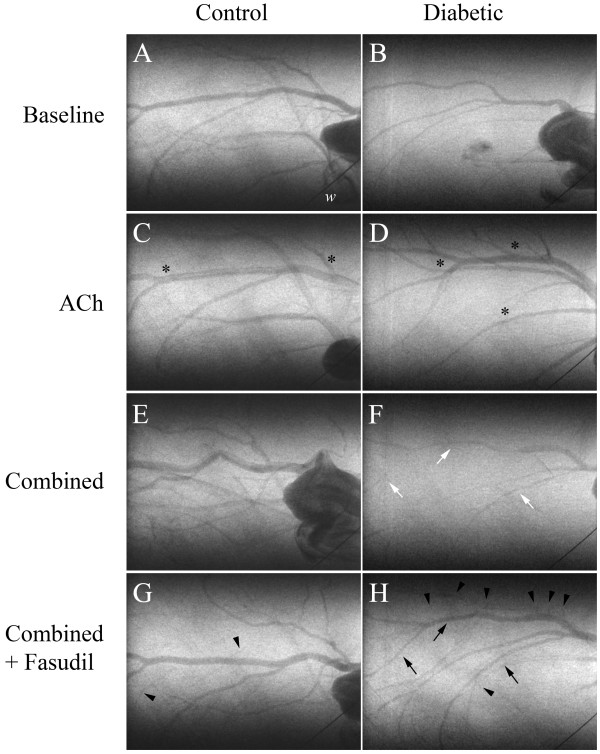
Representative synchrotron radiation angiogram of the coronary vasculature in control and diabetic rats showing segmental constrictions. Baseline lactate infusion (A &B), ACh infusion (C &D; 3.0 μg/kg/min), following administration of L-NAME (10 mg/kg iv. bolus) and meclofenamate (combined, E &F; 2 mg/kg iv. bolus) and subsequent combined + fasudil treatment (G &H; 10 mg/kg iv). A &B, Baseline response to lactate infusion. C &D, Control and diabetic, large vessels maintained vessel ID greater than baseline (black asterisks). E, Control, vessel ID maintained. F, Diabetic segmental vasoconstriction (white arrow). G, Control, vessel ID maintained. H, Vasodilation of medium and small arteries (black arrows) and recruitment of newly visualised small arteries and arterioles relative to baseline (arrowheads). ‘w’ is a 50 μm tungsten wire for vessel ID determination.